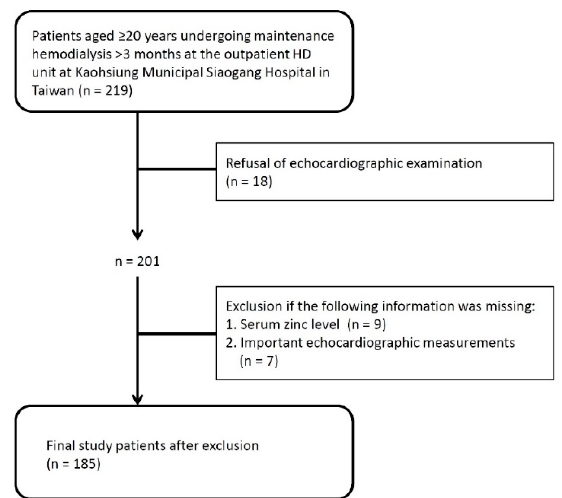
Figure 1. Study population and flowchart.